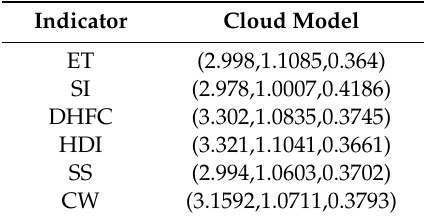
Table 3. Cloud model of evaluation indicator.